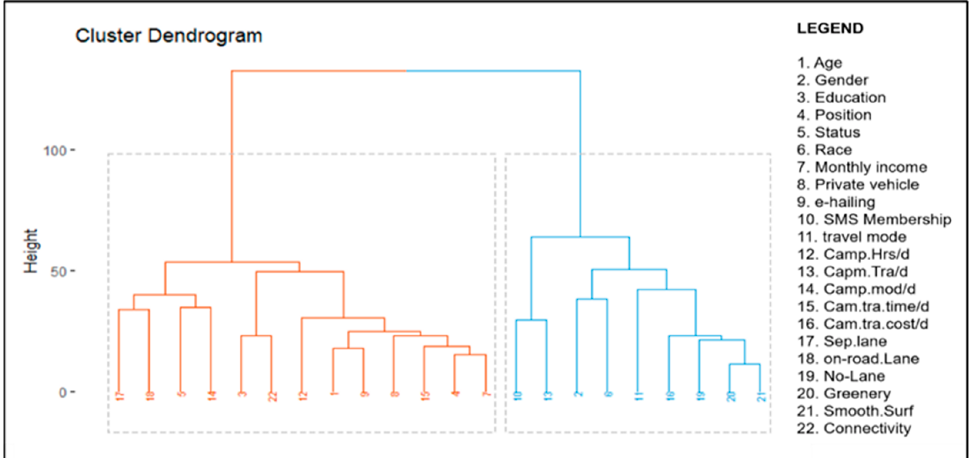
Figure 9. Cluster dendrogram of 22 variables.